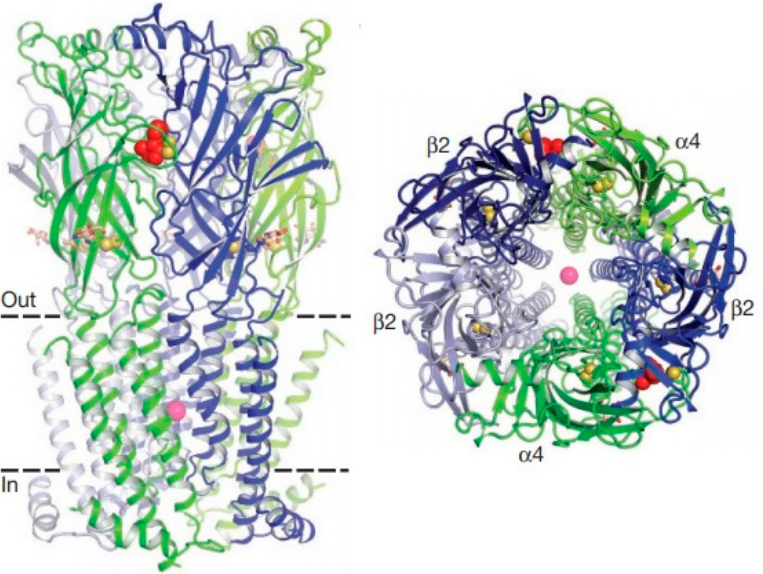
Figure 1. Structure of the nicotinic acetylcholine receptor. Source: Moralles-Perez, Noviello, Hibbs (2016) [97].